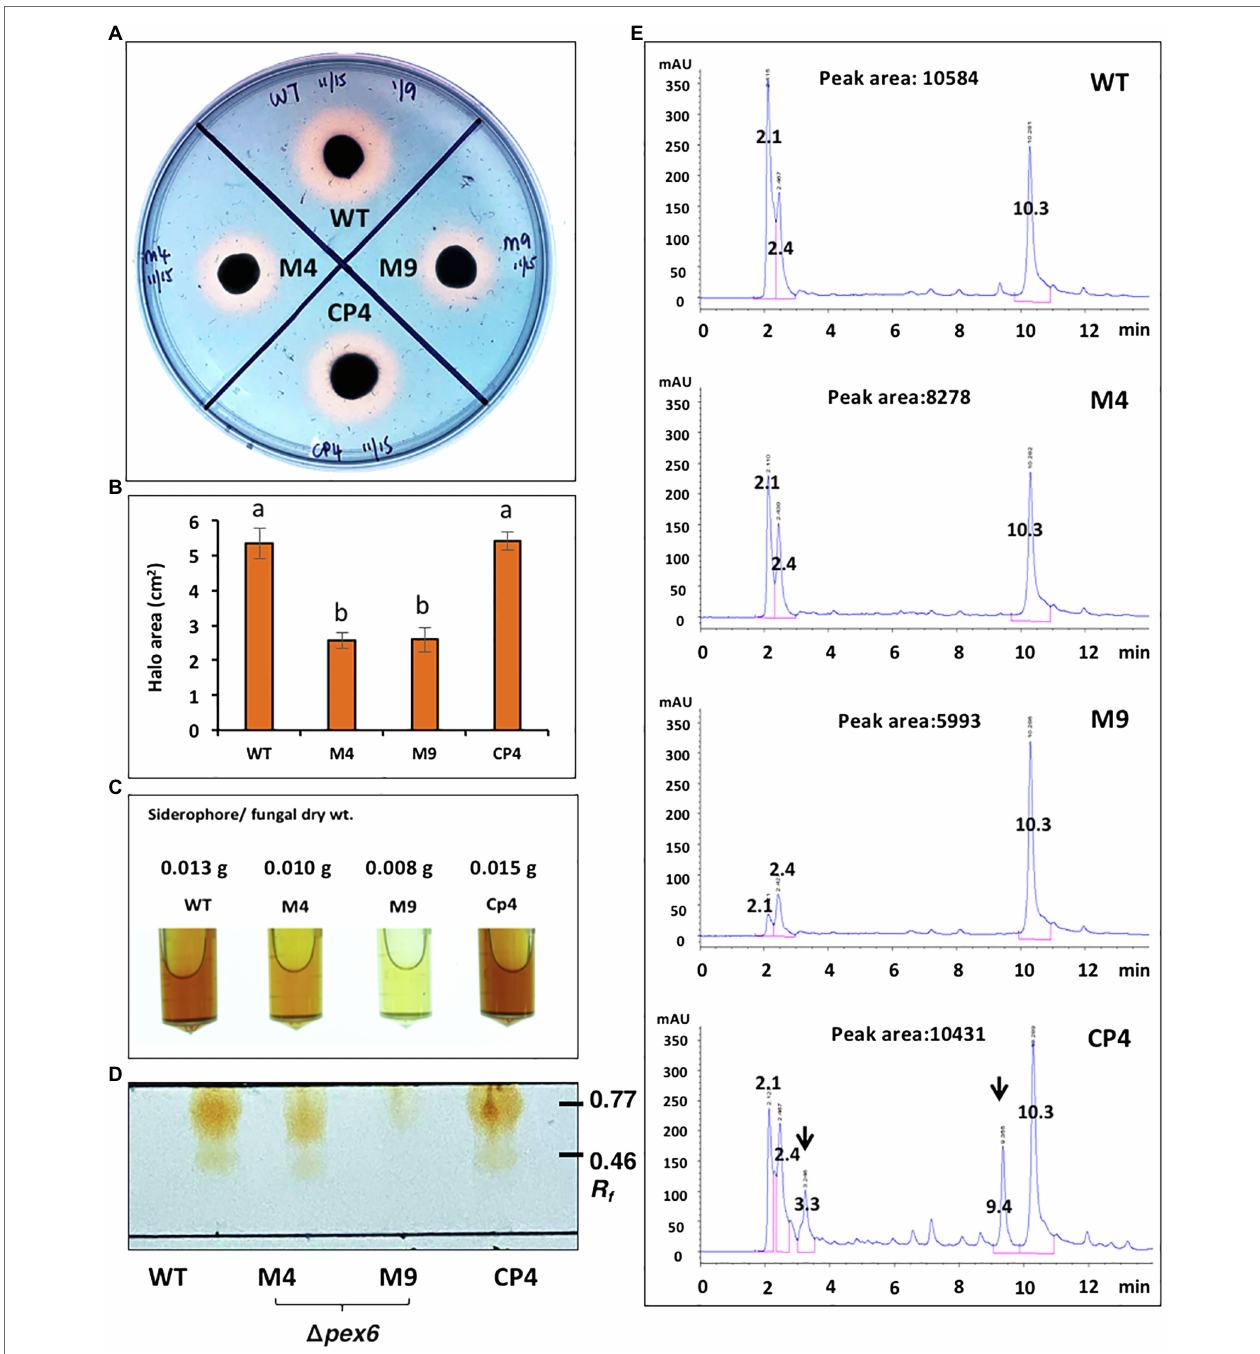
FIGURE 4 | Pex6 is involved in the production of siderophores in A. alternata . (A) Chrome azurol S (CAS) assays for the production of siderophores by wild-type (WT), Δ pex6 (M4 and M9), and the CP4 complementation strains. (B) Quantitative measurement of the area of orange-yellow halos (minus fungal colony). (C) Siderophores purified by Amberlite XAD-16 resins from culture filtrates of fungal strains. (D) TLC analysis of siderophores. (E) HPLC analysis of siderophores purified from fungal strains. The identities of two additional peaks (indicated by arrows) found in the sample prepared from CP4 remain unknown. Peak areas are the sum of three major peaks (retention time: 2.1, 2.4, and 10.3